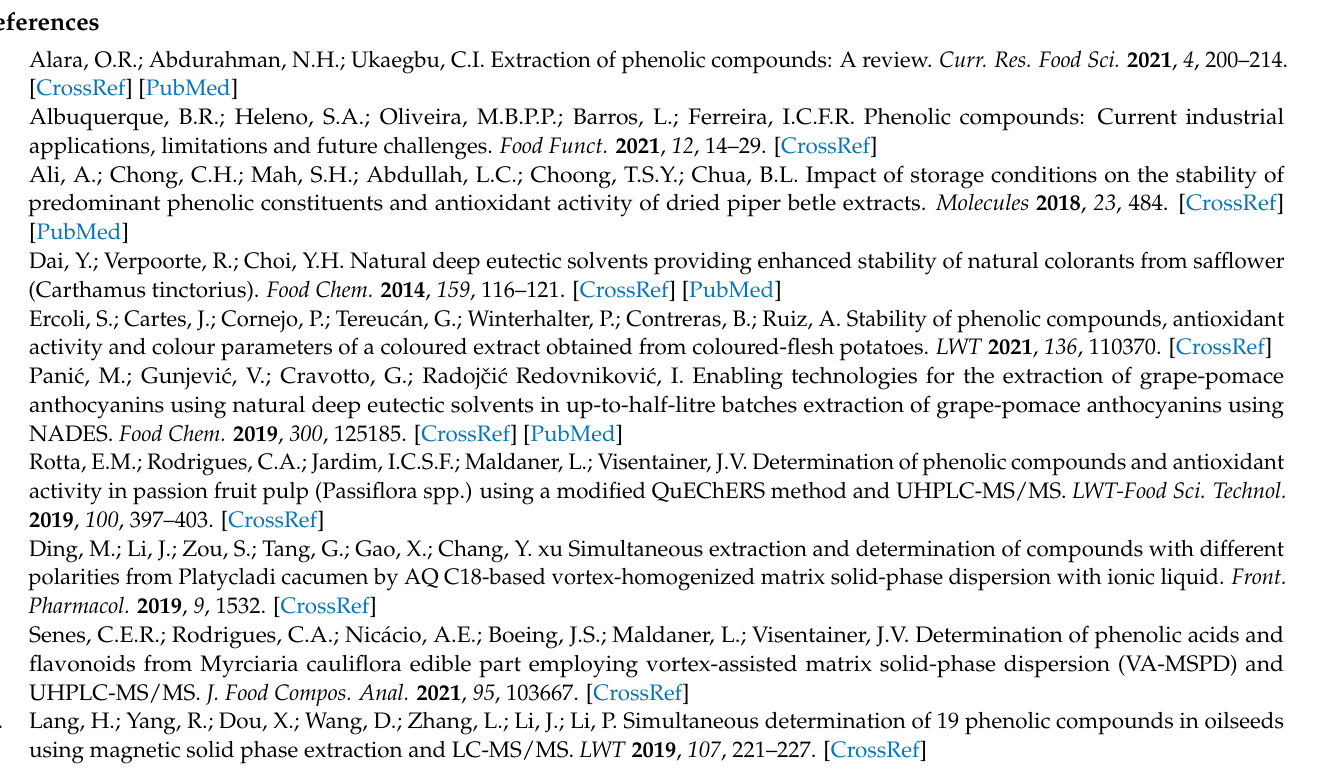
Figure S2: Influence of the extraction solvent on the stability of 5 selected phenolic compounds from H. arenarium , over a period of 0 to 60 days, stored at − 18 ◦ C: (a) chlorogenic acid; (b) naringenin- 4 (cid:48) -O-glucoside; (c) tomoroside A; (d) naringenin-5-O-glucoside; (e) isosalipurposide; (f) naringenin; Figure S3: Influence of the extraction solvent on the stability of 5 selected phenolic compounds from H. arenarium , over a period of 0 to 60 days, stored at 4 ◦ C: (a) chlorogenic acid; (b) naringenin-4 (cid:48) - O-glucoside; (c) tomoroside A; (d) naringenin-5-O-glucoside; (e) isosalipurposide; (f) naringenin; Figure S4: Influence of the extraction solvent on the stability of 5 selected phenolic compounds from H. arenarium , over a period of 0 to 60 days, stored at 25 ◦ C: (a) chlorogenic acid; (b) naringenin-4 (cid:48) -O- glucoside; (c) tomoroside A; (d) naringenin-5-O-glucoside; (e) isosalipurposide; (f)